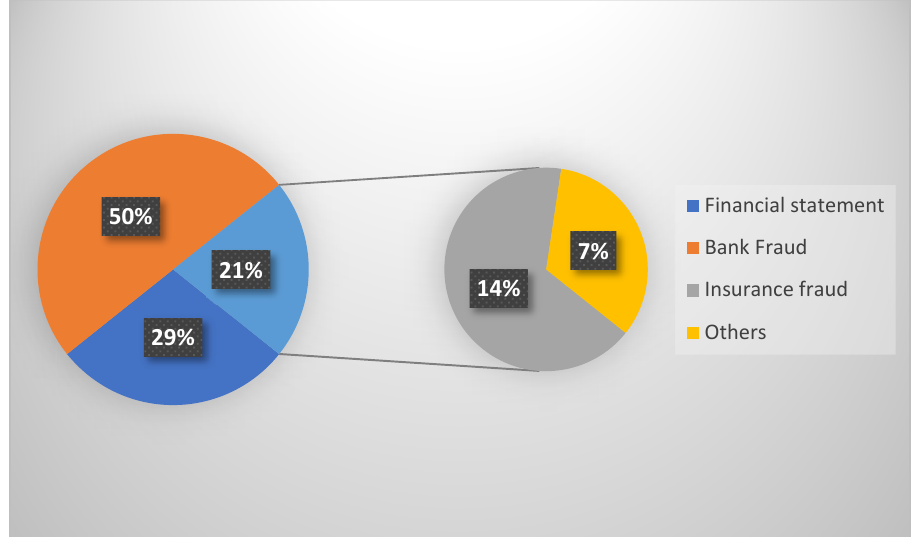
Figure 5. The frequency of the different fraud types.